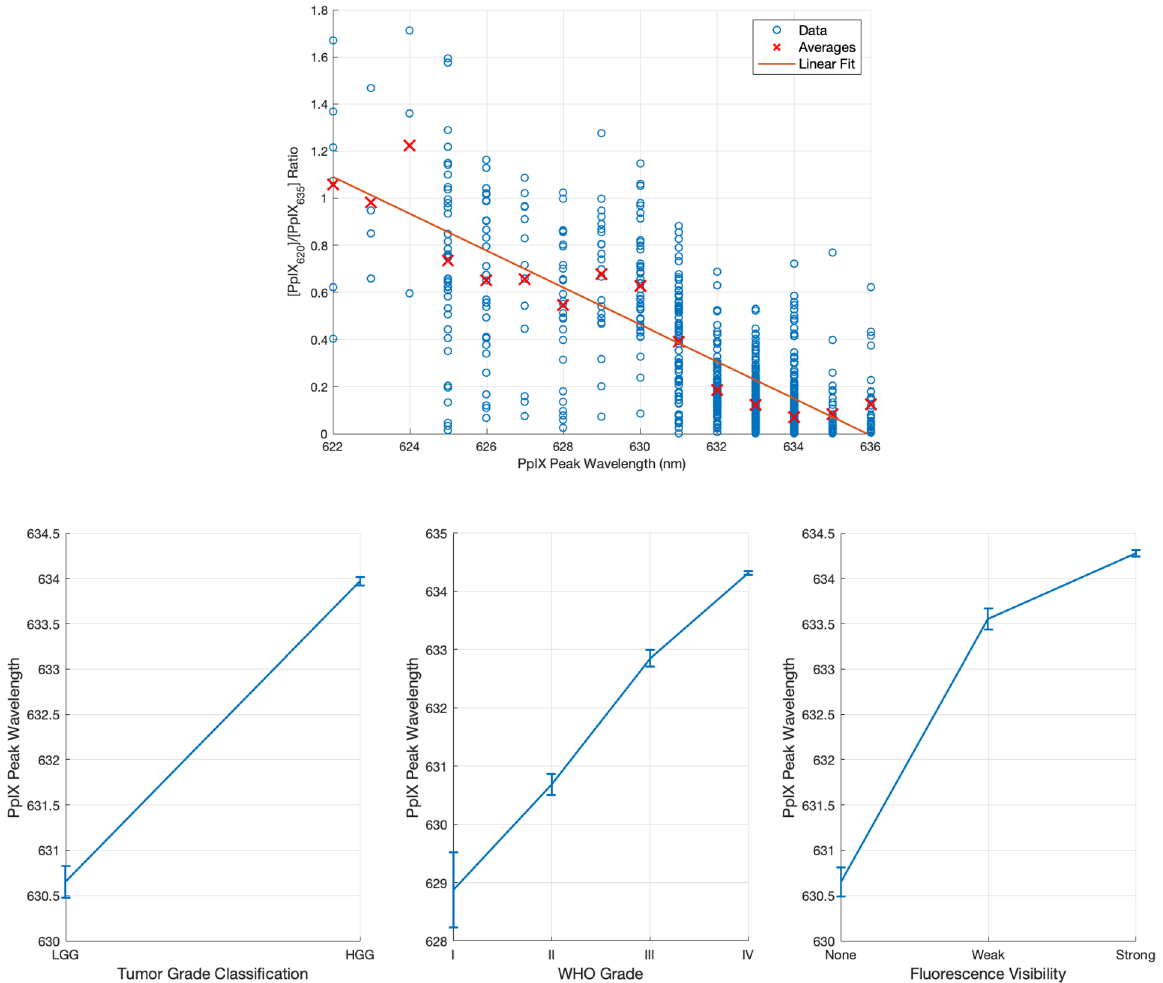
Figure 5. (Top) Ratio 620/634 versus PpIX peak wavelength. The Pearson correlation coefficient is − 0.76, indicating a strong linear correlation. (Bottom) PpIX peak wavelength versus WHO grade, tumor class, and fluorescence visibility, showing strong correlation with each.